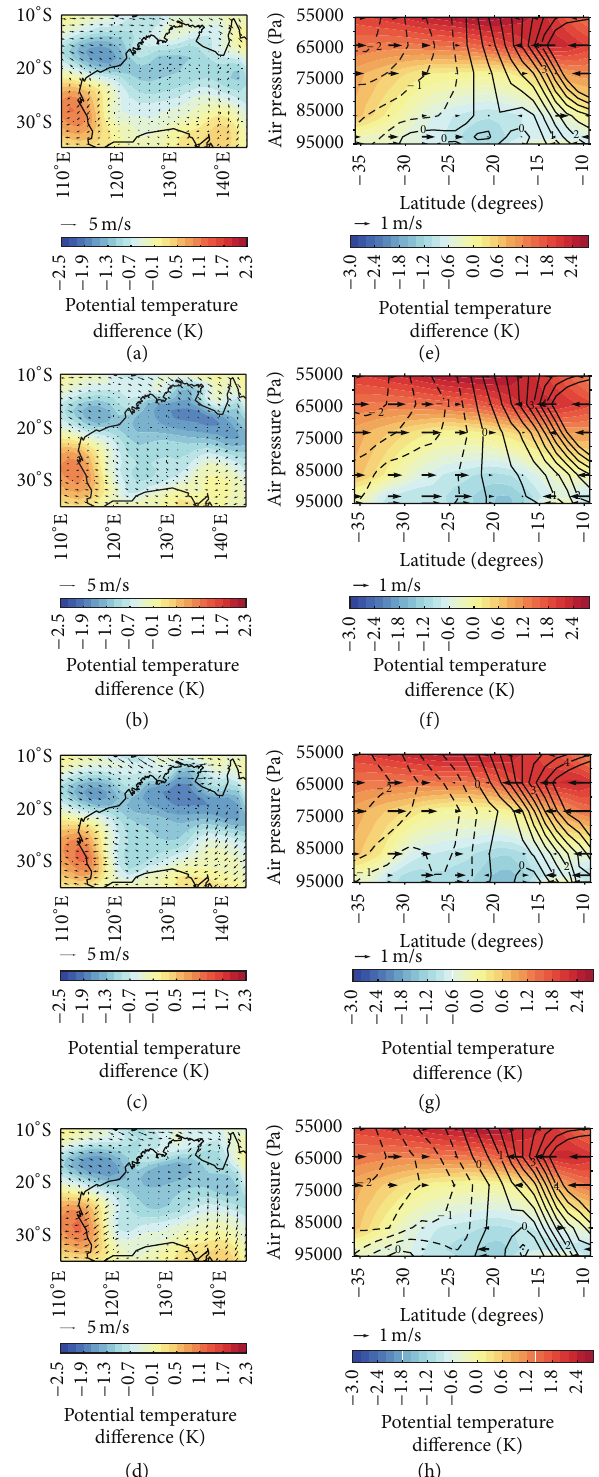
Figure 5: (a)–(d) show the difference in climatological mean (1979–2001) potential temperature (K) and horizontal wind speed (ms −1 ) at 925 hPa between A1.3 and A1.1 at 0800, 1400, 2000, and 0200 AWST, respectively. (e)–(h) show the difference in potential temperature and horizontal wind speed at 125 ∘ E between A1.3 and A1.1 at 0800, 1400, 2000, and 0200 AWST, respectively. The colored contours show the difference in potential temperature. The meridional and vertical wind speeds are indicated by the arrows (scale under each figure) and the zonal wind speeds are shown as the black contours. The dotted and solid black lines represent the zonal flow into and out of the page, respectively. The vertical component is multiplied by a factor of 100 to make it